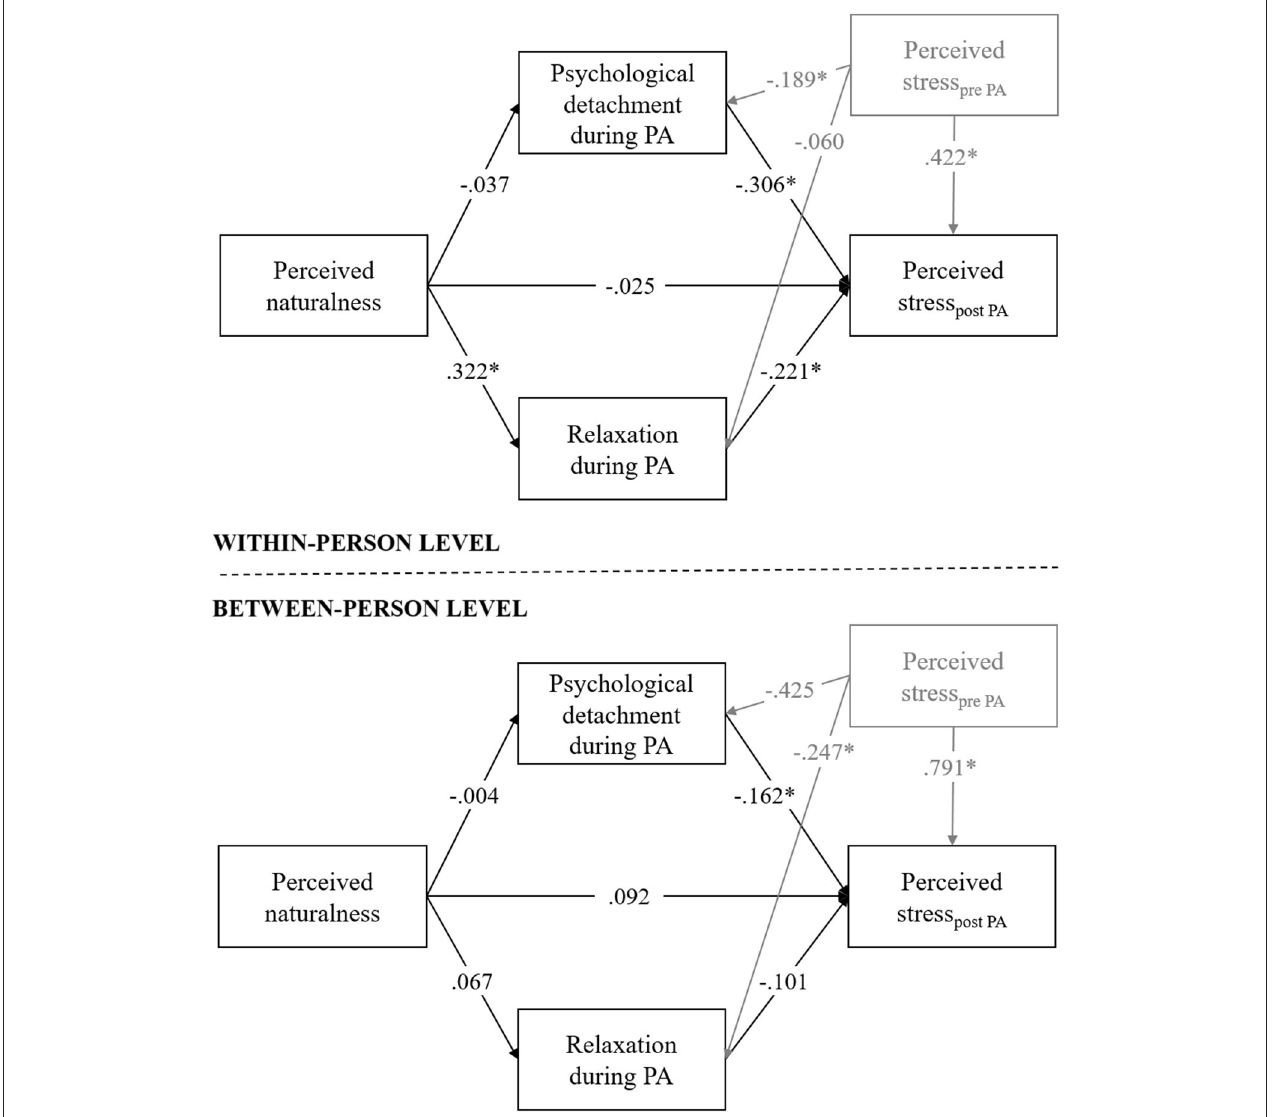
FIGURE 2 | Results of the two-level mediation analysis. All reported regression coefficients (*, p < 0.05) are standardized estimates. For a better overview, control variables are shown in gray. by Hayes and Rockwood (2020). A